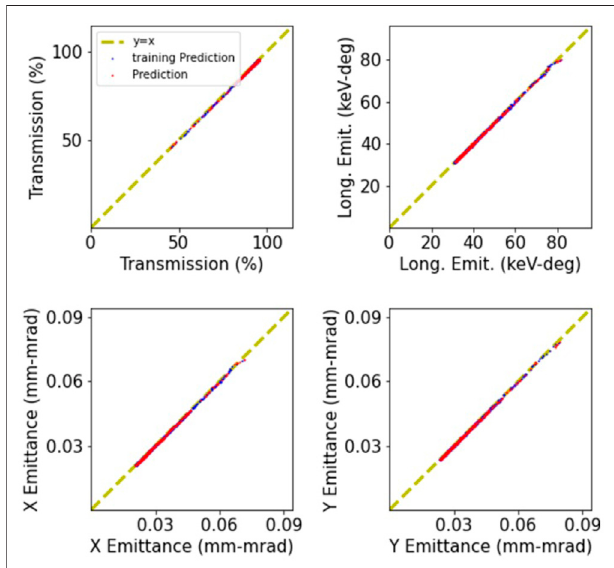
FIGURE 5 | Predictions by the neural network surrogate model as function of the actual data values for variation of only the beam input Twiss parameters to a fi xed RFQ (MAEs being well below 1%). The red dots correspond to the test dataset whereas the blue dots are training